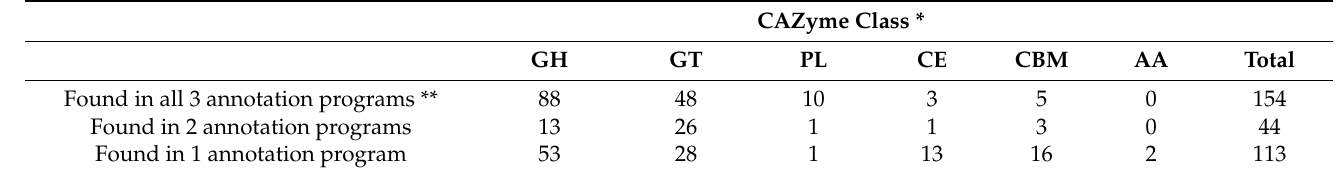
Table 3. CAZymes predicted in the genome of F. faecale WV33 T